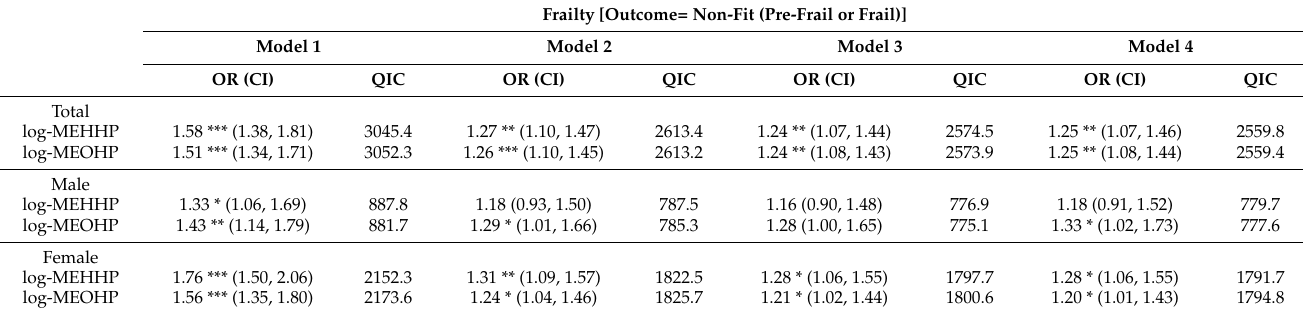
Table 4. Association between log-transformed DEHP concentration and frailty (multivariate, multi-year analysis). Frailty [Outcome= Non-Fit (Pre-Frail or Frail)] Model 1 Model 2 Model 3 Model 4